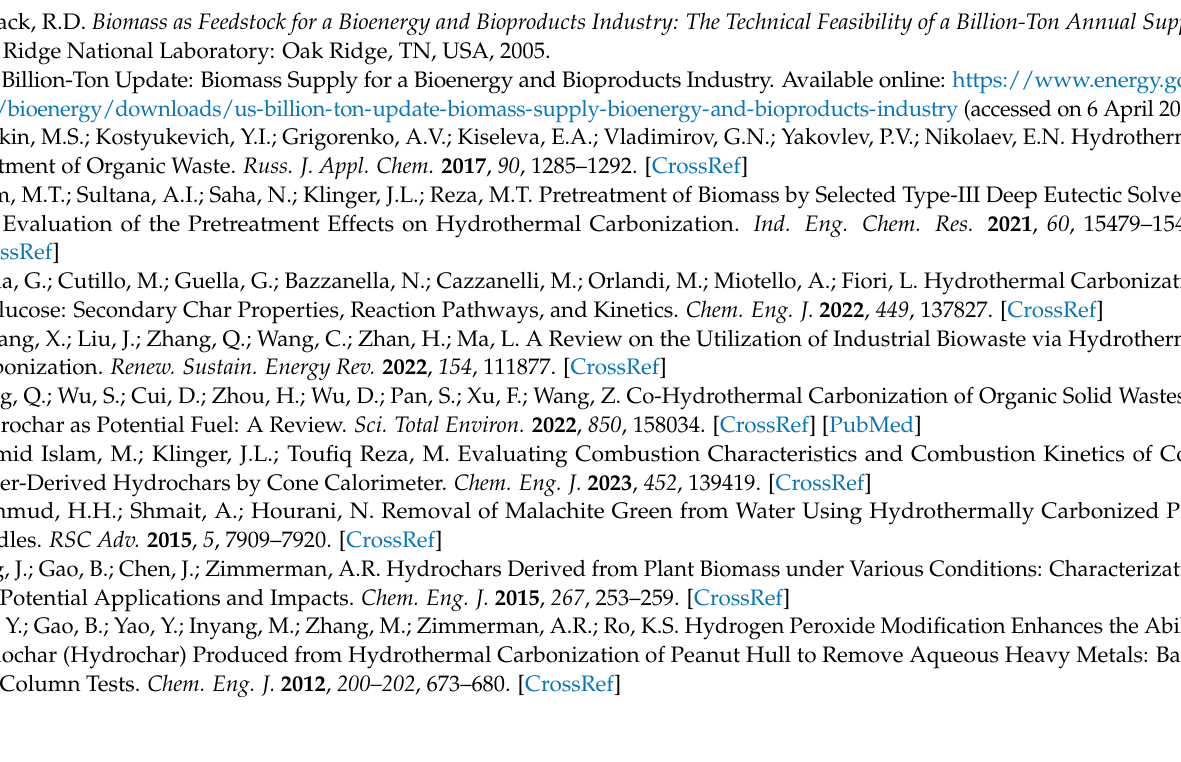
Figure S2: CO 2 /N 2 gas adsorption of superactivated hydrochars (SAH180, SAH220, SAH260); Table S1: Elemental analysis of loblolly pine, hydrochar and superactivated hydrochars, Table S1: Literature comparison for methylene blue dye removal adsorbent from various biomass, Table S3: Literature comparison for electron storage material from various biomass, Table S4: Separation factor of Table S5: Langmuir-Freundlich isotherm model fitting parameters for carbon dioxide capture and electron